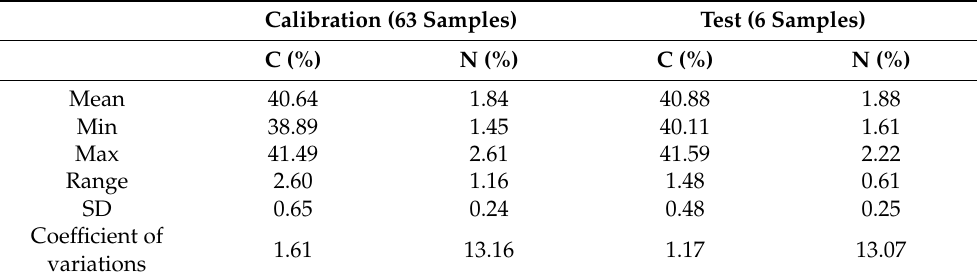
Table 1. Descriptive analysis measured using wet chemistry